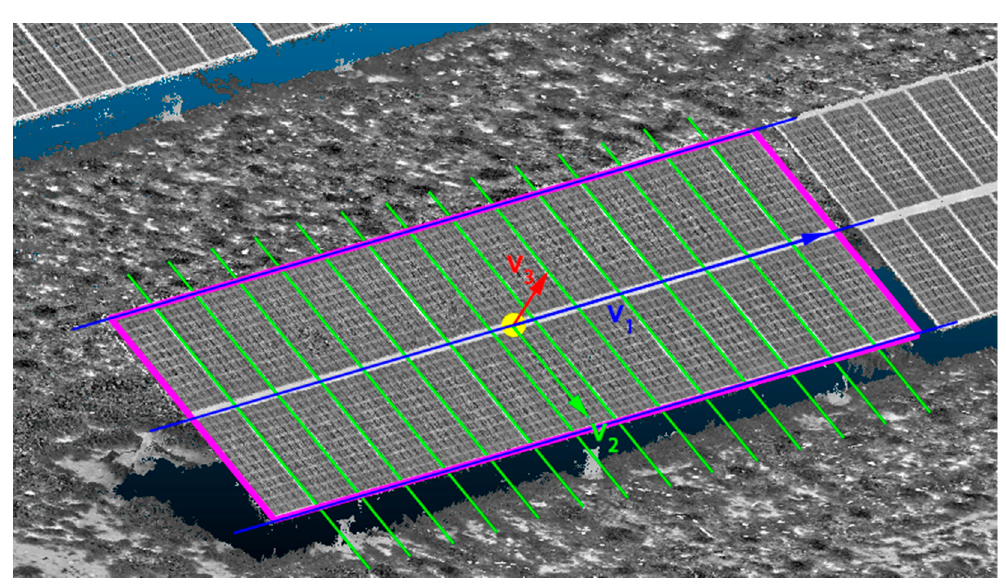
Figure 6. Distribution of RANSAC lines parallel to PCA v 1 and v 2 eigenvectors. Projection over plane Z = 0 is used as PV panel segmentation grid.